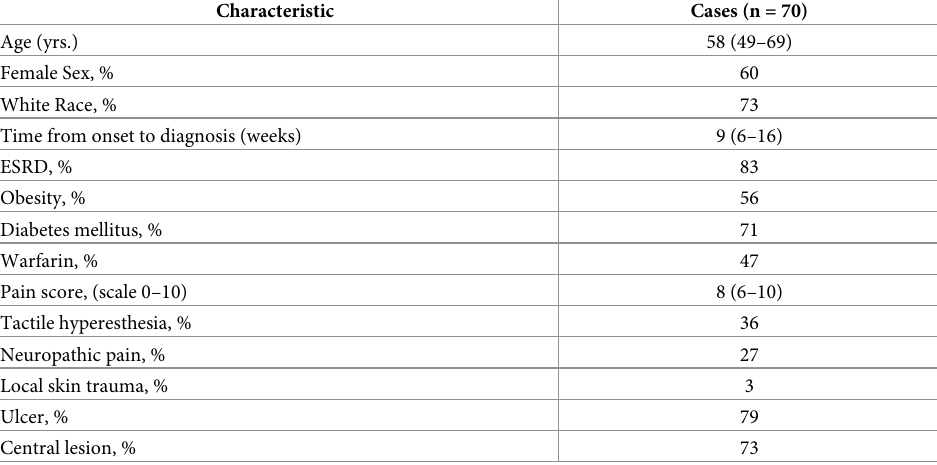
Table 1. Summary of clinical